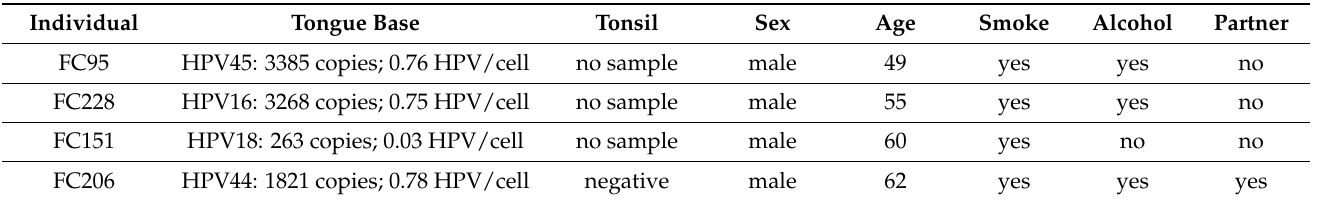
Table 3. Details of positive samples.